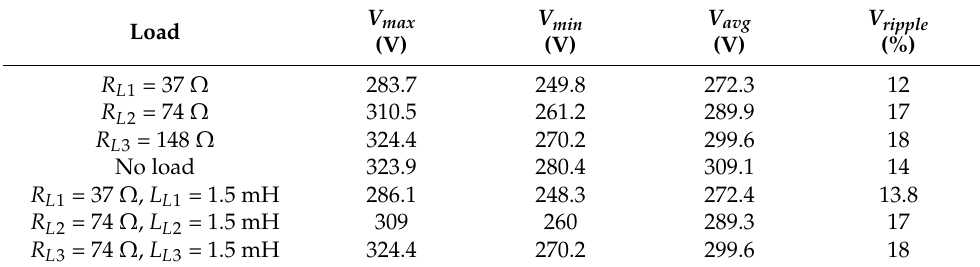
Table 13. ATU with input capacitor filter—simulation results.